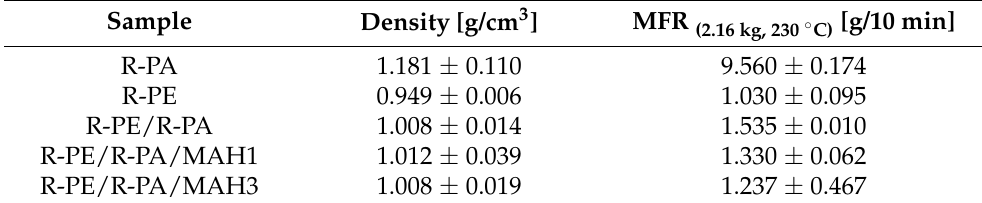
Table 2. Results of density and melt flow rate (MFR) of